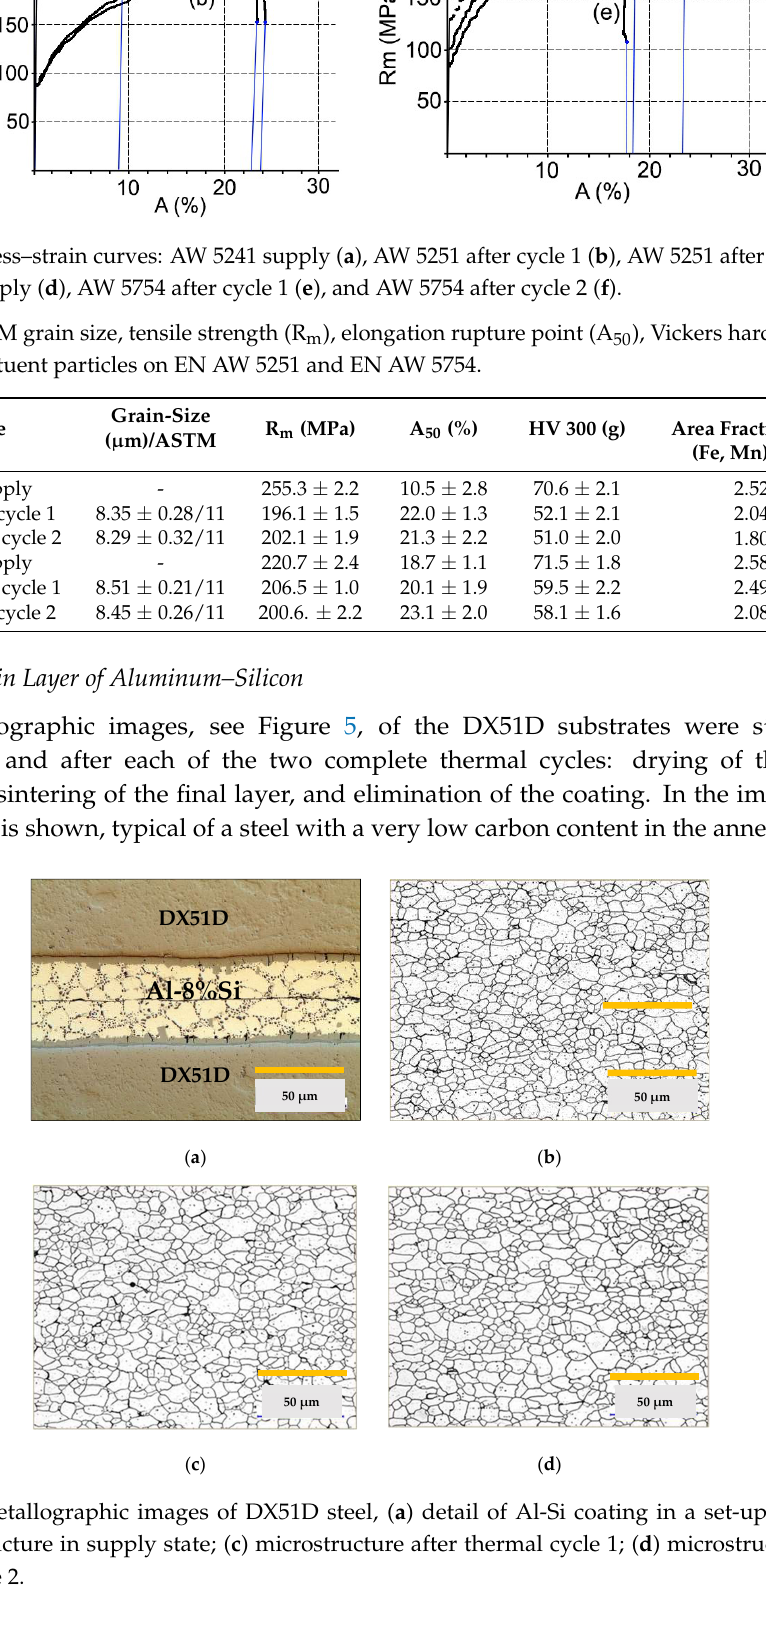
Figure 6. Stress–strain curve: DX51D supply (g); DX51D after cycle 1 (h); DX51D after cycle 2 (i). Table 3. ASTM grain-size, tensile strength (R m ), elongation of rupture (A 50 ), Vickers hardness (HV) of steel DX51D and average diameter (μm) of the micro-constituent dendrites α (Al) of the layer of Al- Si. State